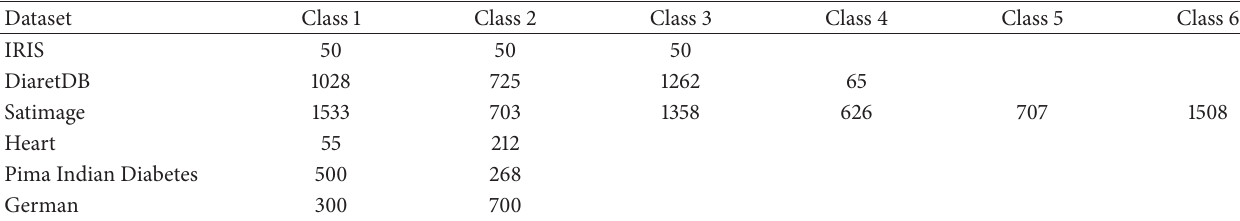
Table 2: Description of number of instances present in each class of datasets.